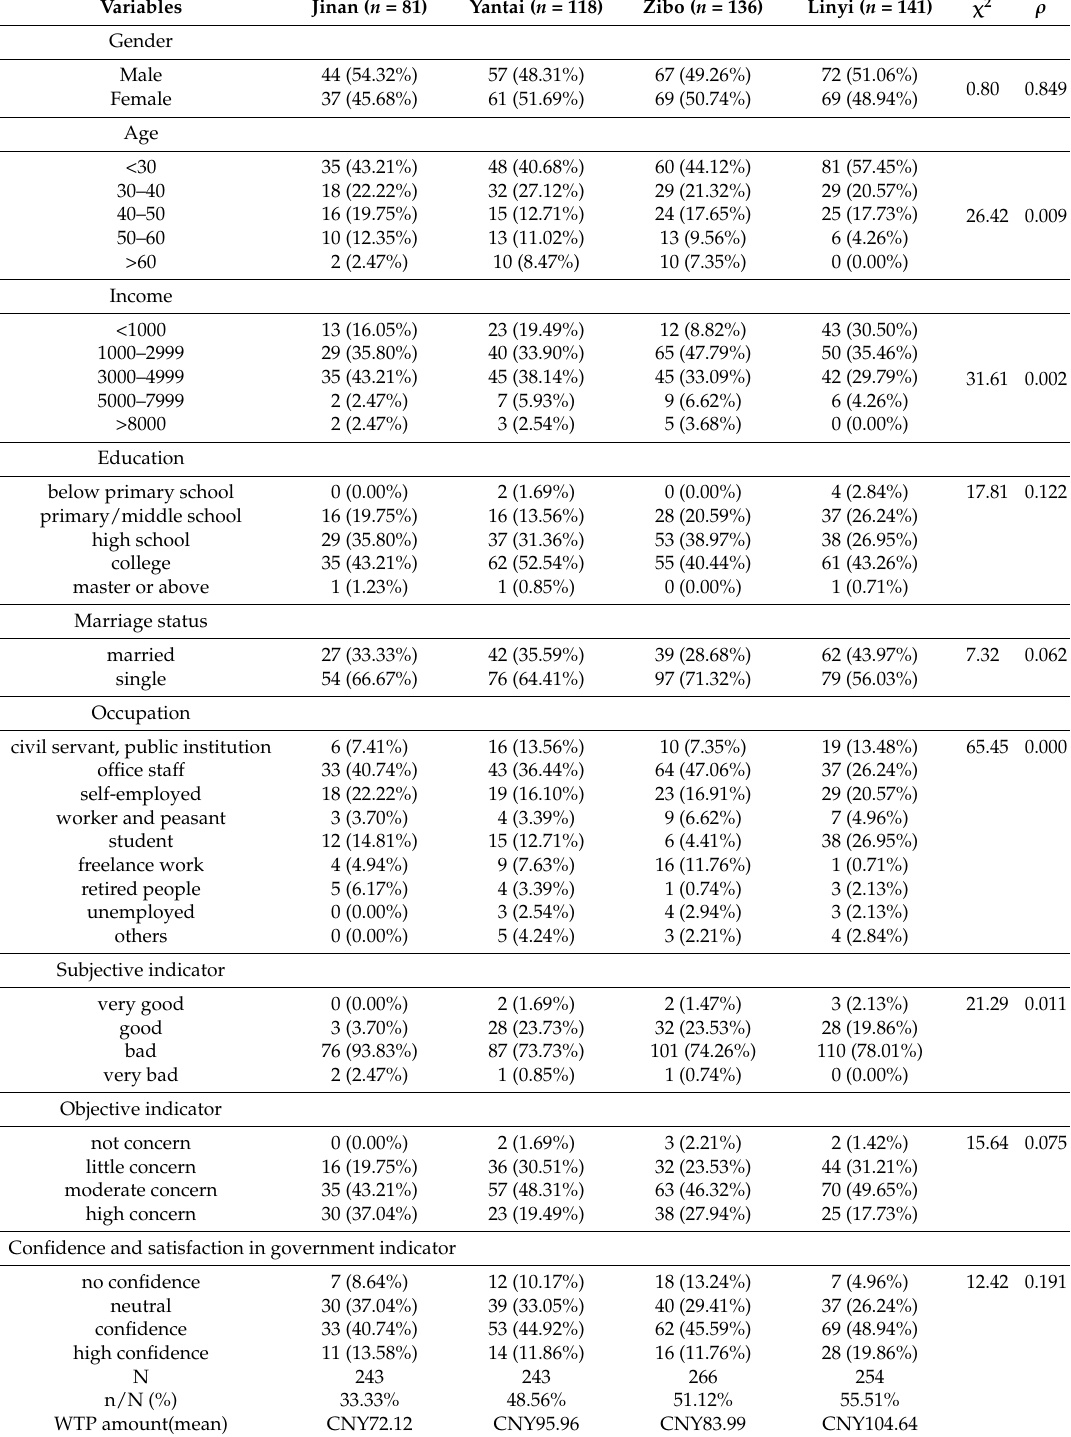
Table 6. Socio-economic characteristics and haze attitudes toward people with positive